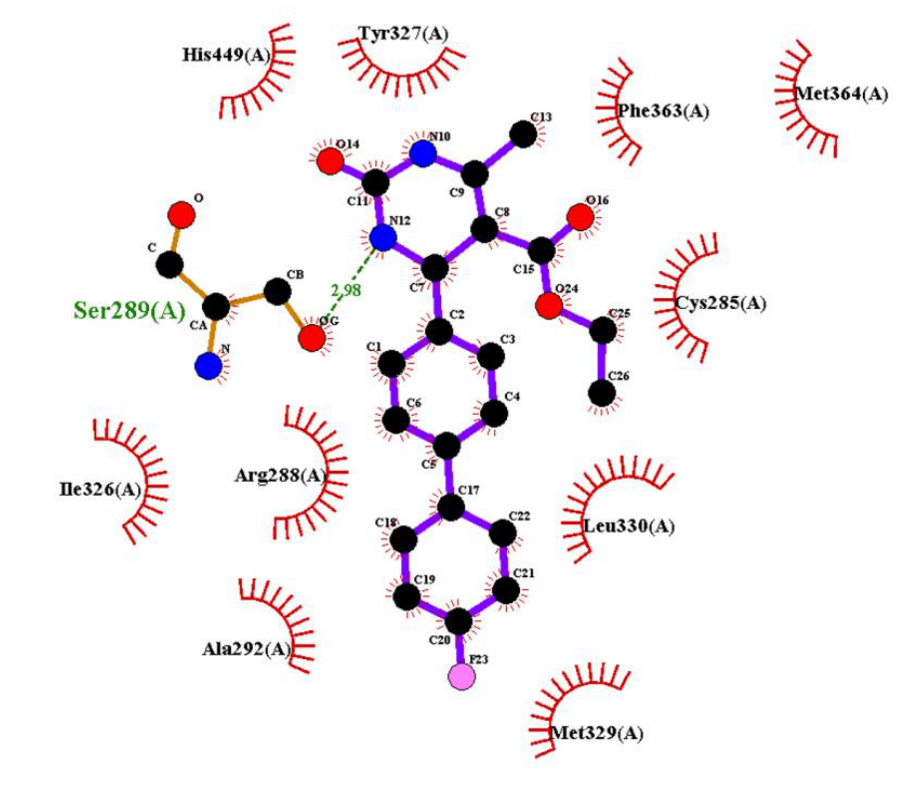
Figure 8. Ligplot images showing the hydrophobic interactions of 4d with the receptor PPAR- γ.